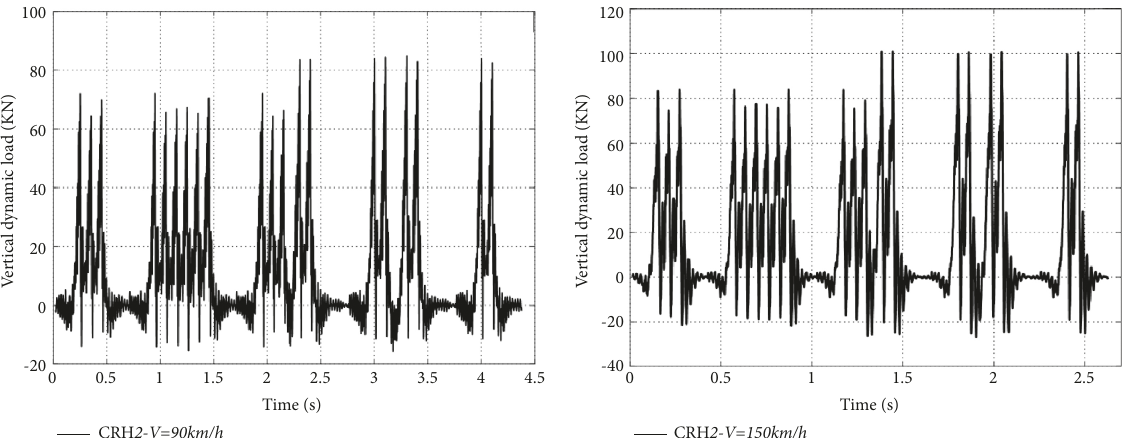
Figure 10: Wheel-rail excitation histories at different vehicle speeds.